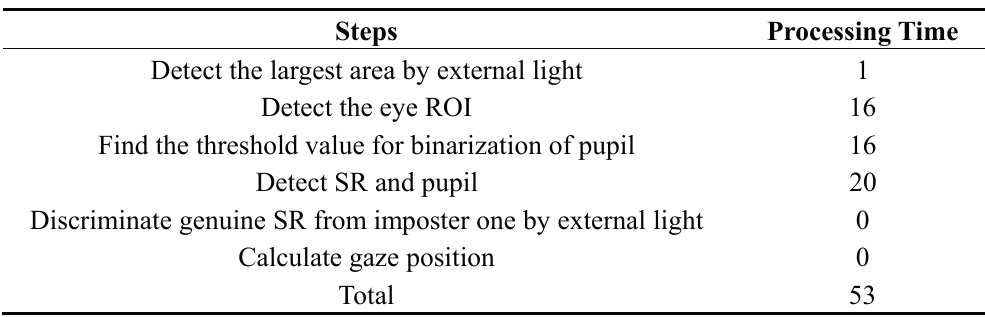
Table 7. Processing time of our method (unit: